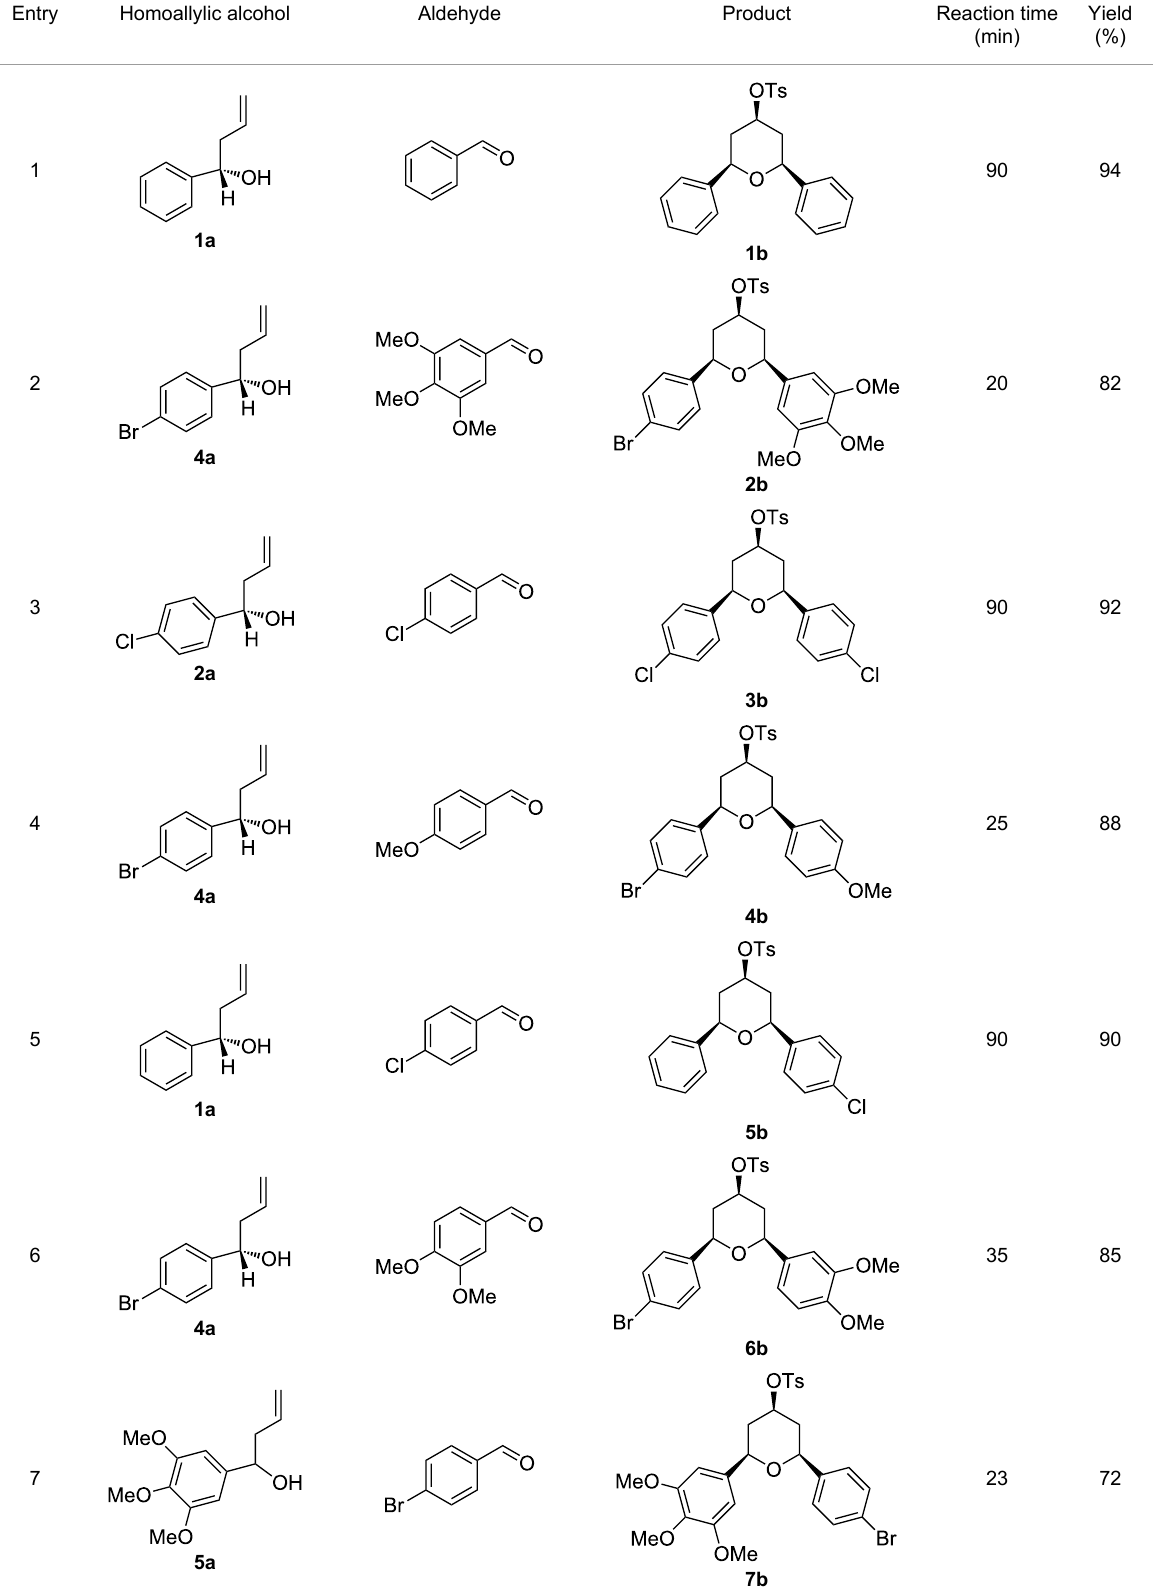
Table 2: Preparation of tetrahydropyrans from aromatic homoallylic alcohols, aldehydes and PTSA·H 2